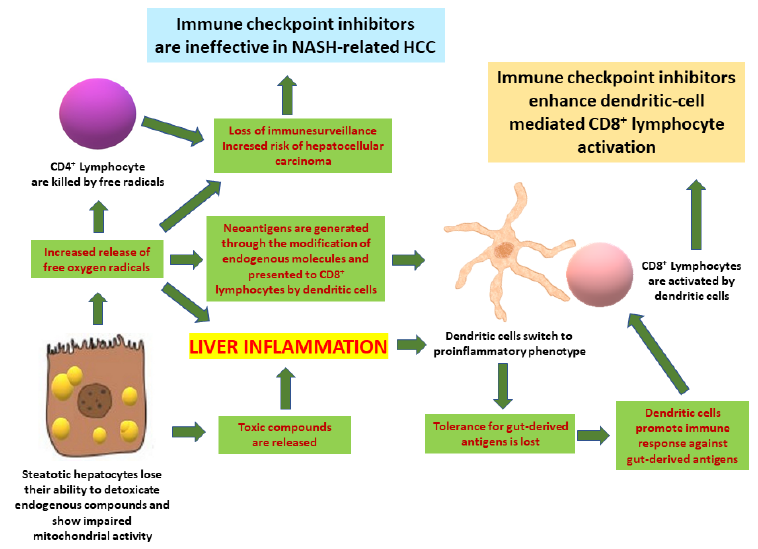
Figure 1. Interrelationship between steatohepatitis and pharmacological effects of immune check- point inhibitors in the liver.